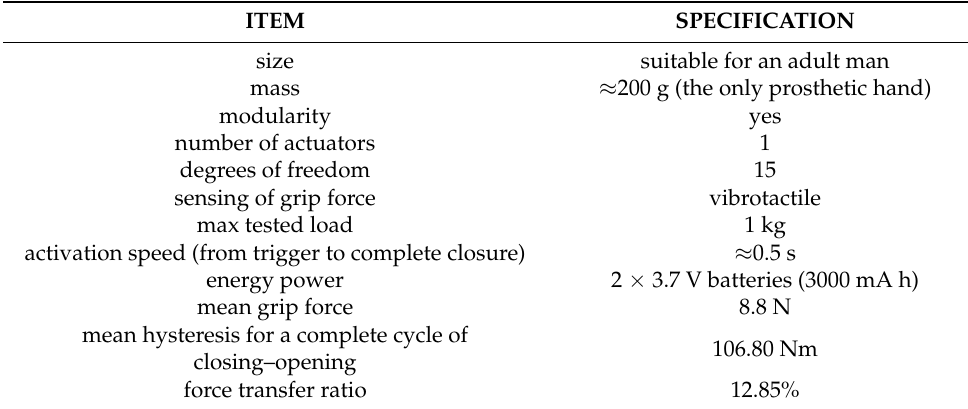
Table 1. Design specifications for the “Federica” hand.